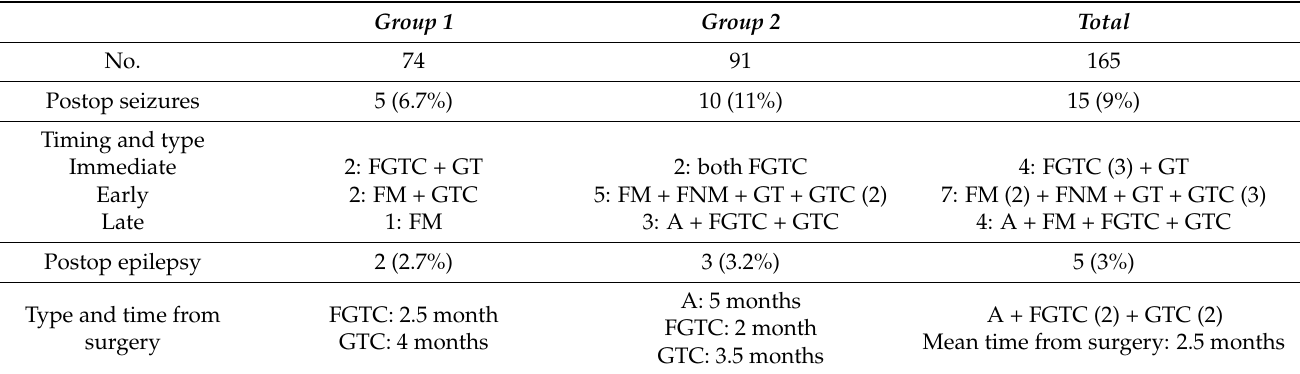
Table 2. Postoperative